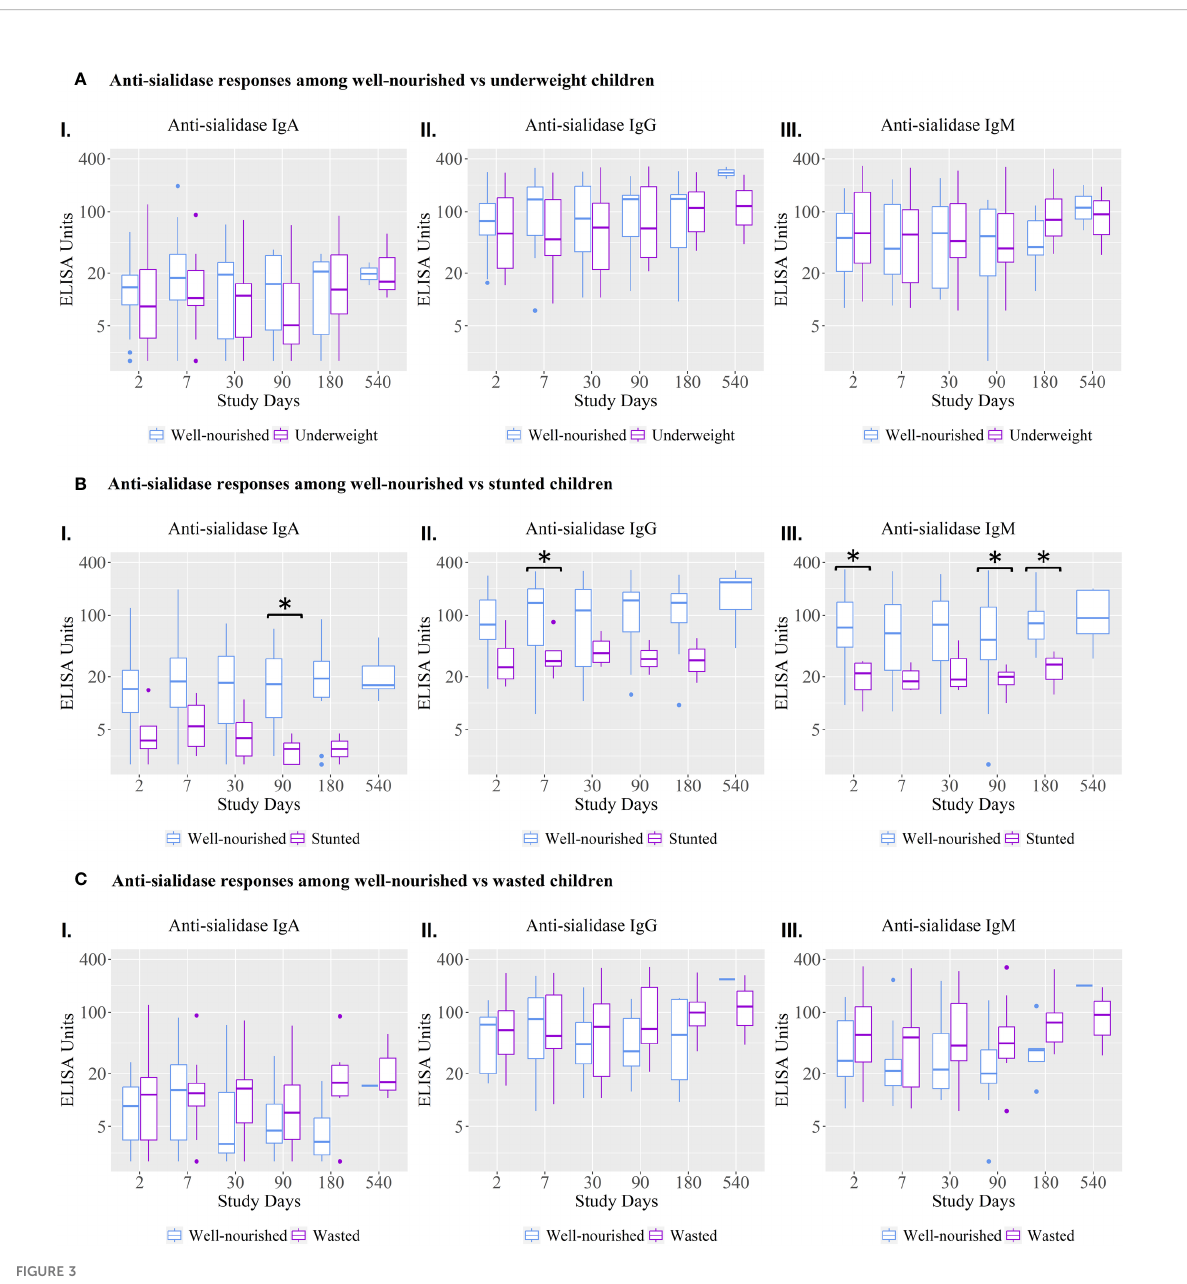
FIGURE 3 Anti-sialidase IgA, IgG, and IgM antibody responses among well-nourished versus malnourished children. Underweight = weight-for-age; Wasted= weight-for-height; Stunted = height-for-age. Children with a Z score < − 2 were categorized as moderately or severely undernourished for that category. Children with a Z score ≥ − 2 were categorized as non-moderately or severely malnourished. Kruskal-Wallis test has done in order to identify the signi fi cant difference in median responses of anti-sialidase. Asterisks denote the level of signi fi cance; *p=0.05- 0.01 and ** denotes p=0.01-0.001. The black asterisks denote the difference between well-nourished and malnourished